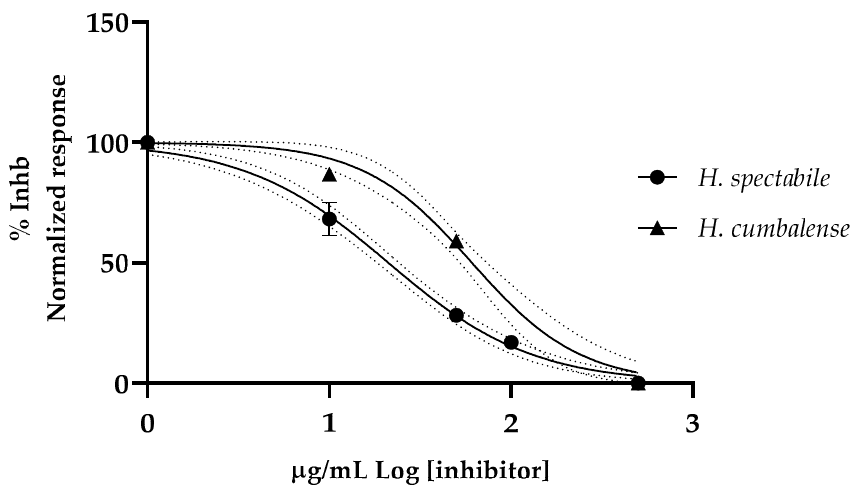
Figure 1. Inhibitory effect graph of H. spectabile and H. cumbalense , EO, against acetylcholinesterase. Data were built from three replicas of three different experiments and analyzed by the non-linear regression model.